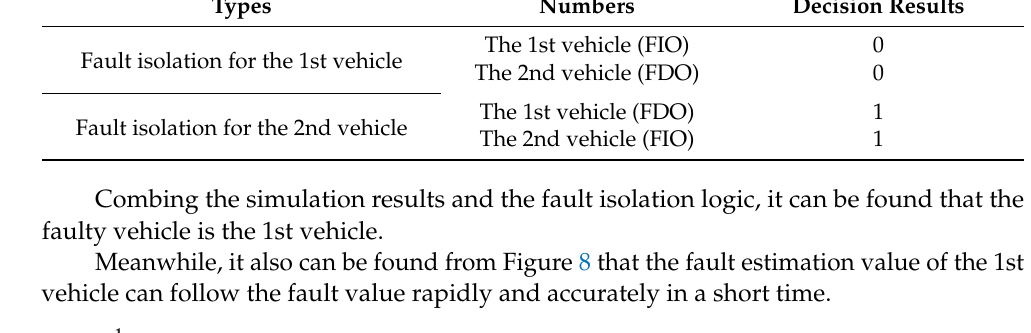
Figure 8. The actual value and estimation value of 1 ( ) f k .